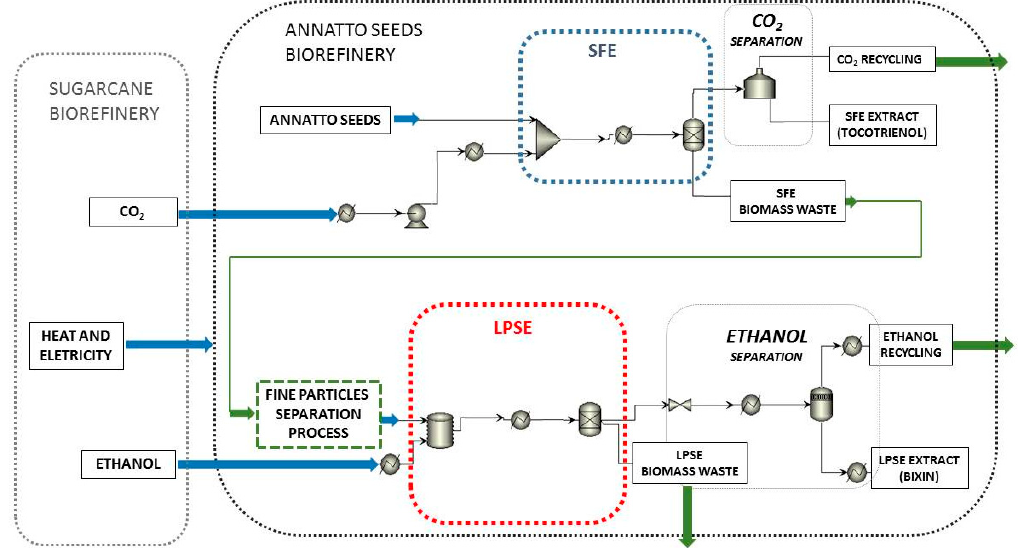
Figure 1. Simplified process representation for the proposed conceptual process design that uses supercritical fluid extraction process during the first stage of annatto seeds valorization processing. Table 1. Main parameters considered for simulation of each configuration analyzed.